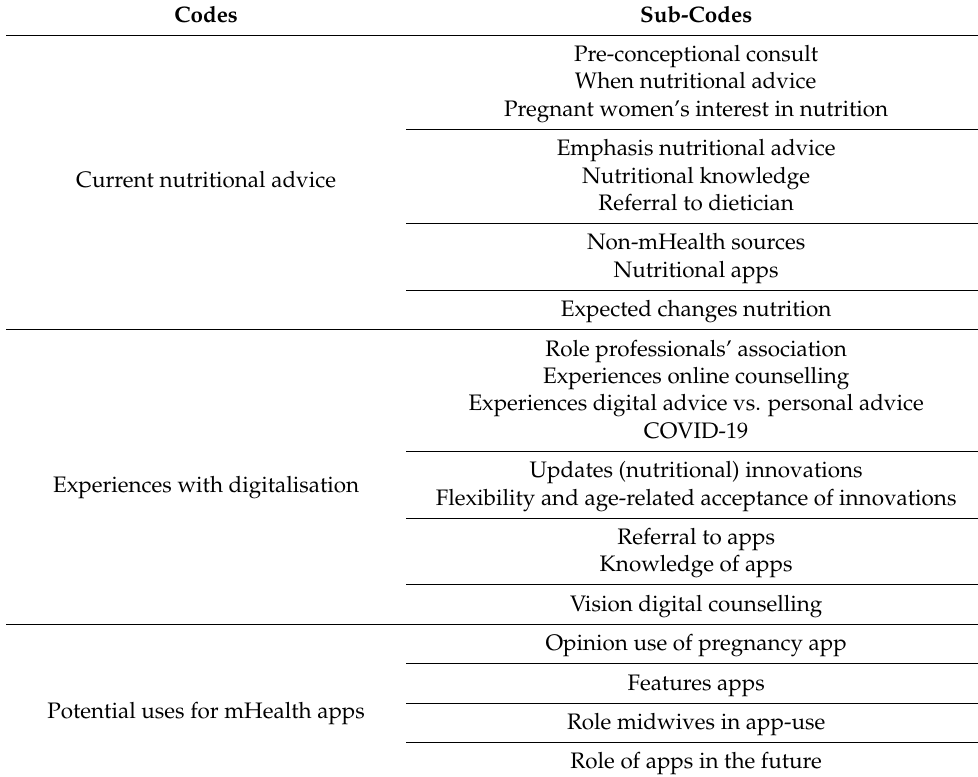
Table A1. Codes and